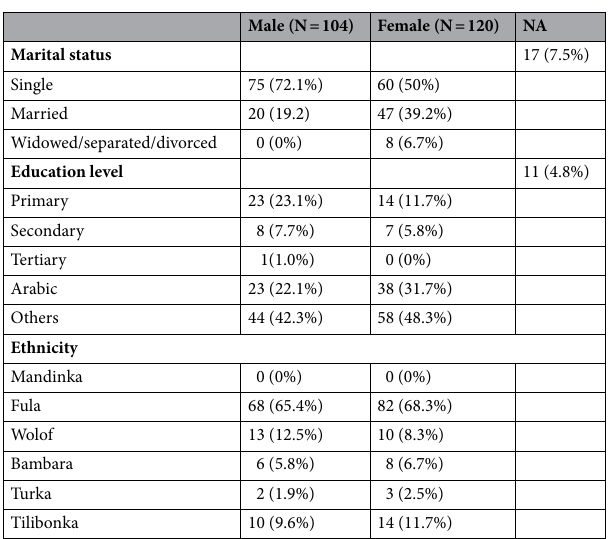
Table 2. Socio-demographic characteristics of respondents in survey (N = 227).